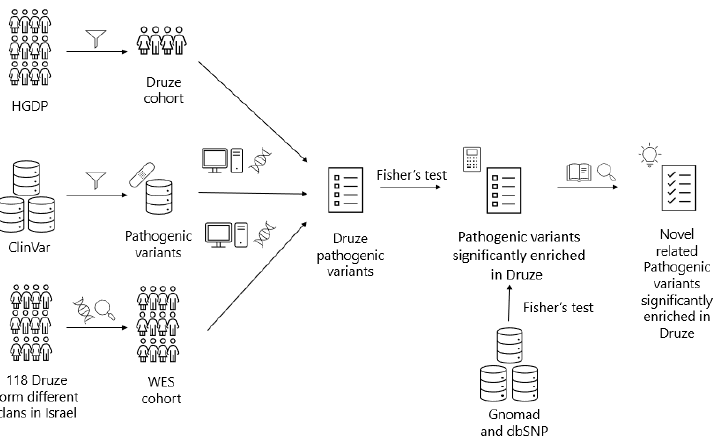
Figure 1. Methodology flow diagram: HGDP-derived data was filtered based on Druze ethnicity to create a Druze cohort of 40 individuals. Additionally, exome sequencing was performed on 118 Druze individuals from different clans in Israel, creating the WES cohort. Simultaneously, all the variants from ClinVar were filtered based on interpretation labeled as “pathogenic” or “likely pathogenic”. Then, the Druze-cohort variants and the WES-cohort variants were cross referenced with the catalogue of the pathogenic variants from ClinVar creating the Druze pathogenic-variants list. Only variants that were classified as “pathogenic” or “likely pathogenic” according to the ACMG-AMP guidelines were included in the list. We compared the allele frequency of each variant in our cohort and the allele frequency of the variants in worldwide populations based on the data from gnomAD and dbSNP. Using Fisher’s test, we identified the variants that were significantly different in Druze. After a literature review, we narrowed down the list to obtain a curated set of pathogenic variants that are enriched in the Druze population in comparison to other populations.